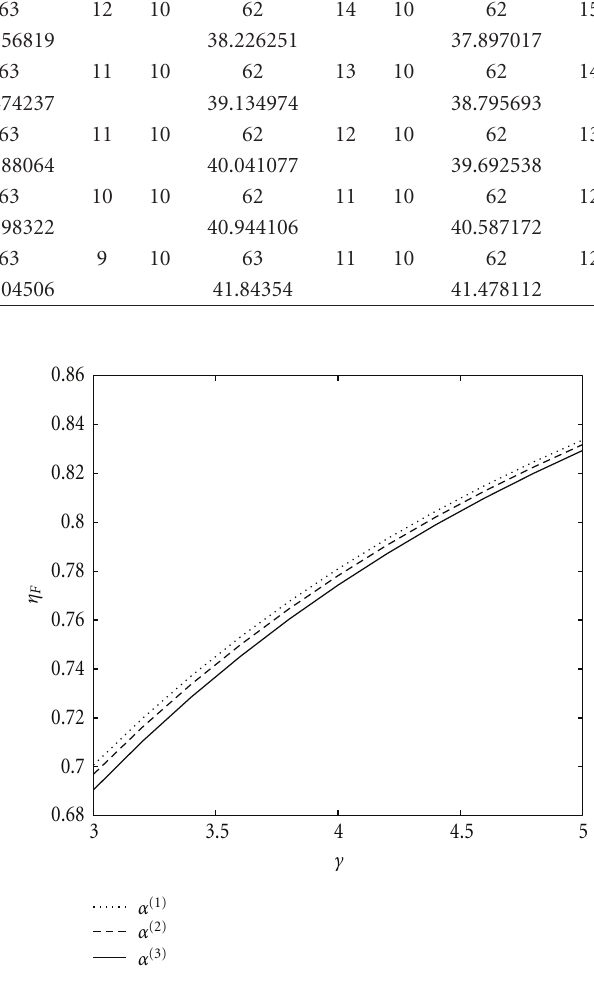
Figure 5: Fraction of time server is on vacation— γ versus α ( n ) ( S = 90, s = 15, N = 25, β = 1 . 4, λ = 8, μ = 0 . 8, p = 0 . 75 .